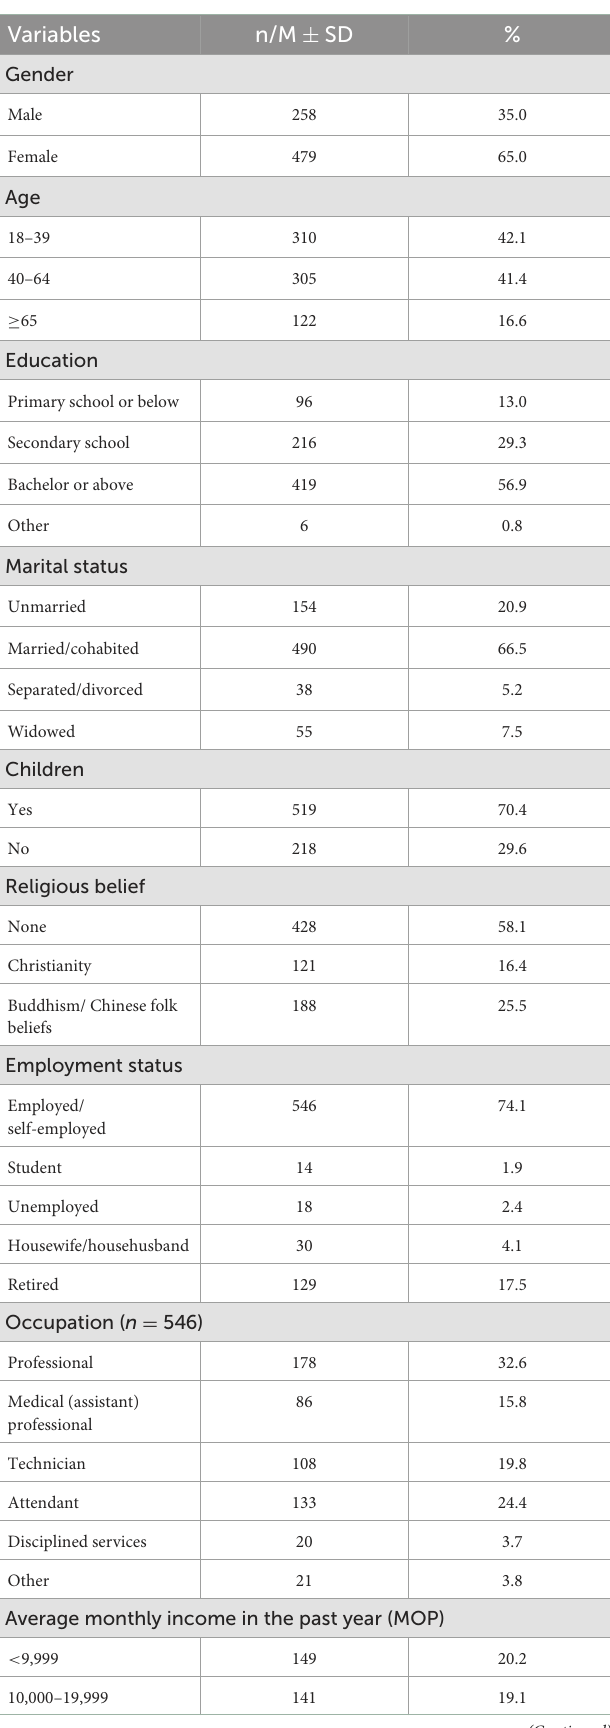
TABLE 1 Sociodemographic characteristics of participants ( N =